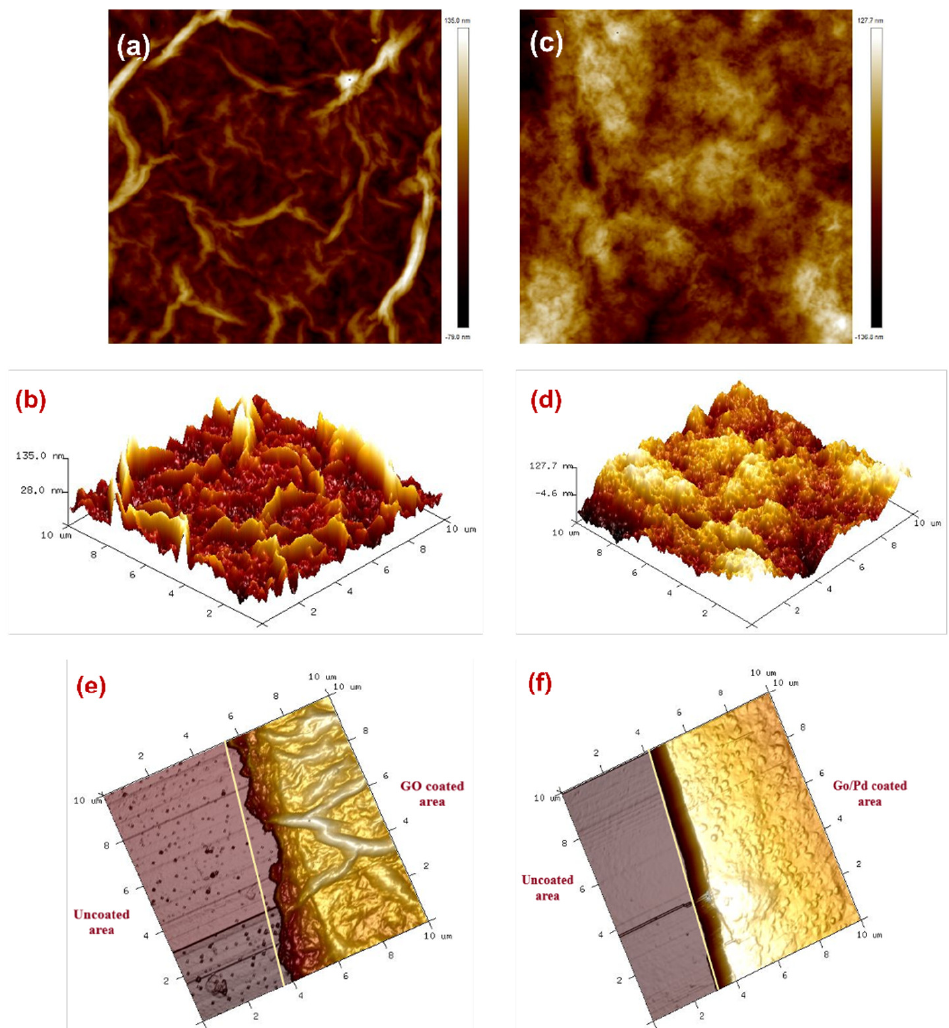
Figure 11. 2D topography of AFM images of ( a ) GO and ( c ) Pd/GO composite. 3D AFM images of ( b ) GO and ( d ) Pd/GO composite. 3D AFM topography images of the boundary region between the uncoated and coated fibers of ( e ) GO and ( f ) the Pd/GO composite sensor layer.